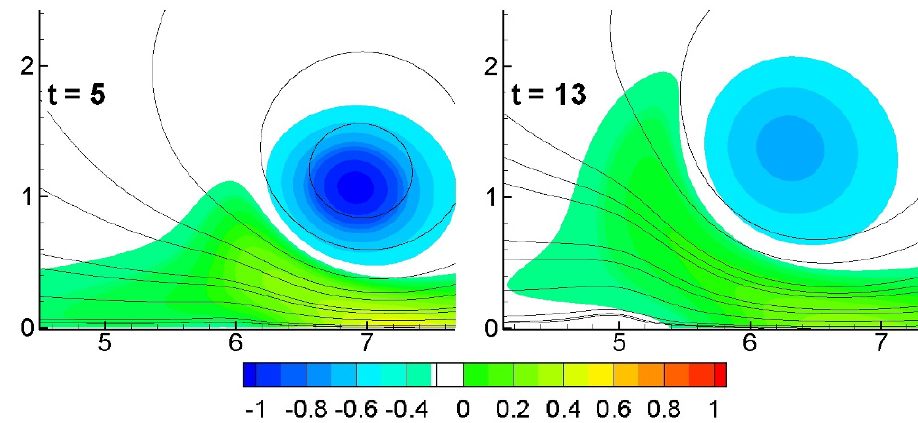
Figure 4. Interaction of the vortex patch and the wall for Re = 500 . A strong diffusion process can be observed. The figure shows the vorticity field with selected streamlines.